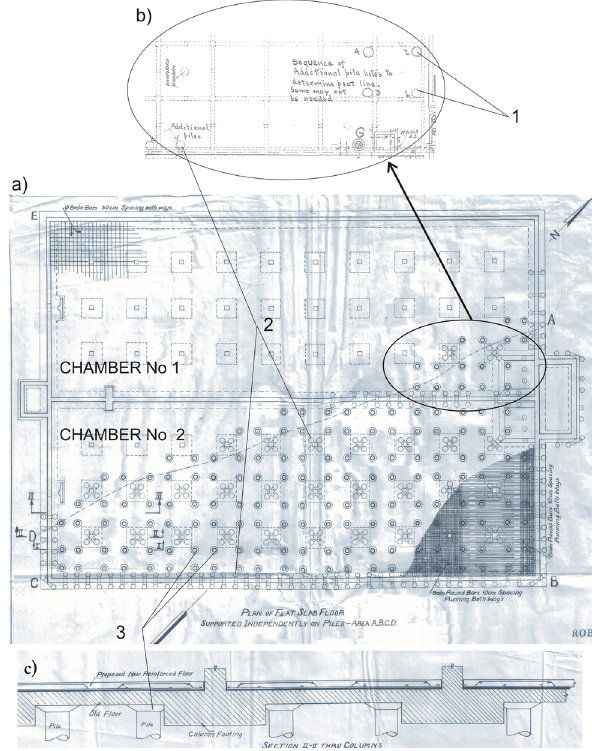
Figure 8: Original design drawings concerning the